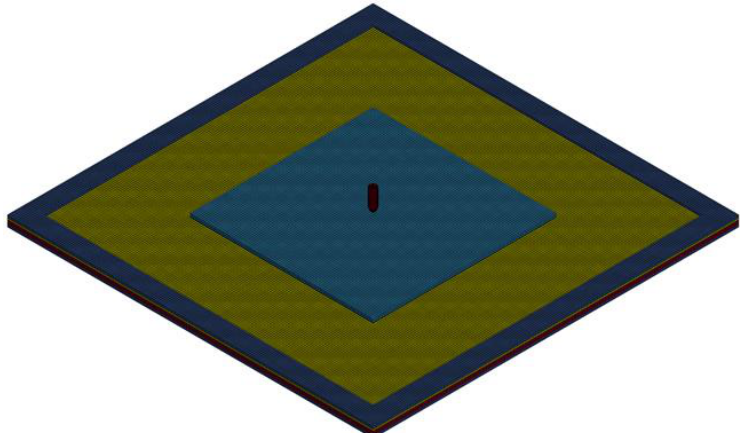
Figure 6. Computational model of transparent sandwich structure.